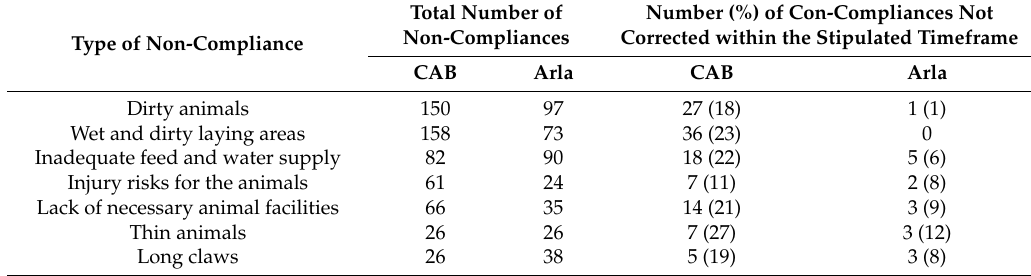
Table 6. Total numbers of the seven most common non-compliances and percentages not corrected within the stipulated timeframe (more than one follow-up inspection carried out before compliance was registered) found in official animal welfare control (CAB = County Administrative Board)